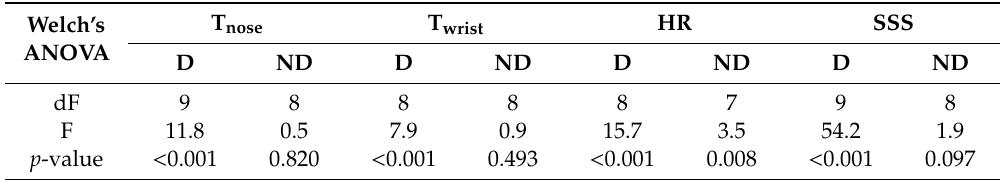
Figure 4. Average trend of T nose , T wrist , heart rate (HR), and Stanford sleepiness scale (SSS) in drowsy and non-drowsy subjects. ( a ) T nose in drowsy subjects, ( b ) T nose in non-drowsy subjects, ( c ) T wrist in drowsy subjects, ( d ) T wrist in non-drowsy subjects, ( e ) HR in drowsy subjects, ( f ) HR in non-drowsy subjects, ( g ) SSS in drowsy subjects, ( h ) SSS in non-drowsy subjects. Table 1. Statistics of the Welch’s ANOVA tests. The “degrees of freedom” for each test are indicated by dF. F indicates the corresponding F-statistic. “D” refers to the group of drowsy drivers and “ND” to the non-drowsy